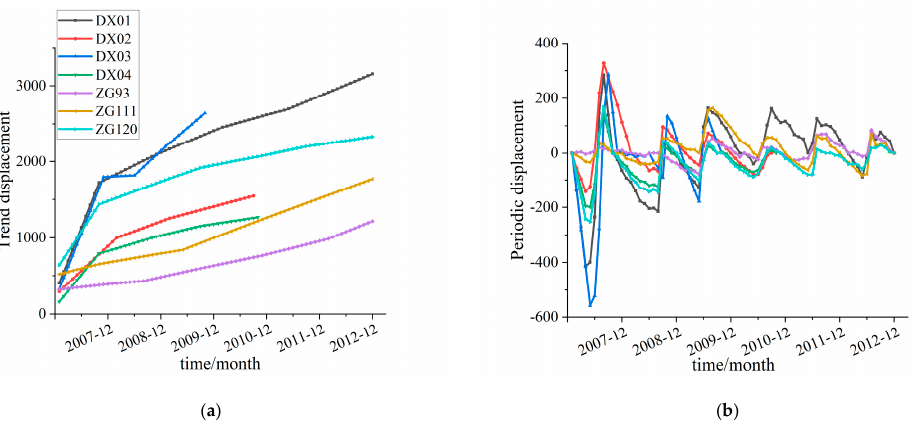
Figure 11. Trend and periodic displacement of all GPS stations decomposed by DDM. ( a ) Trend displacement. ( b ) Periodic displacement.